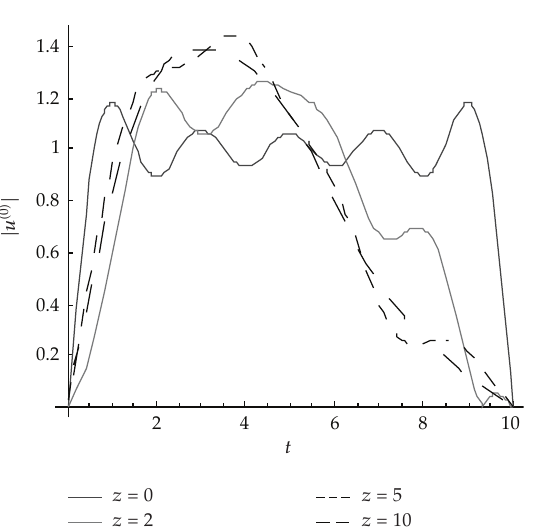
Figure 26: The zero-order approximation | u (cid:3) 0 (cid:4) | at α (cid:8) 1, T (cid:8) 10, γ (cid:8) 02 for di ff erent values of z , considering only one term in the series (cid:3) M (cid:8) 1 (cid:4) .